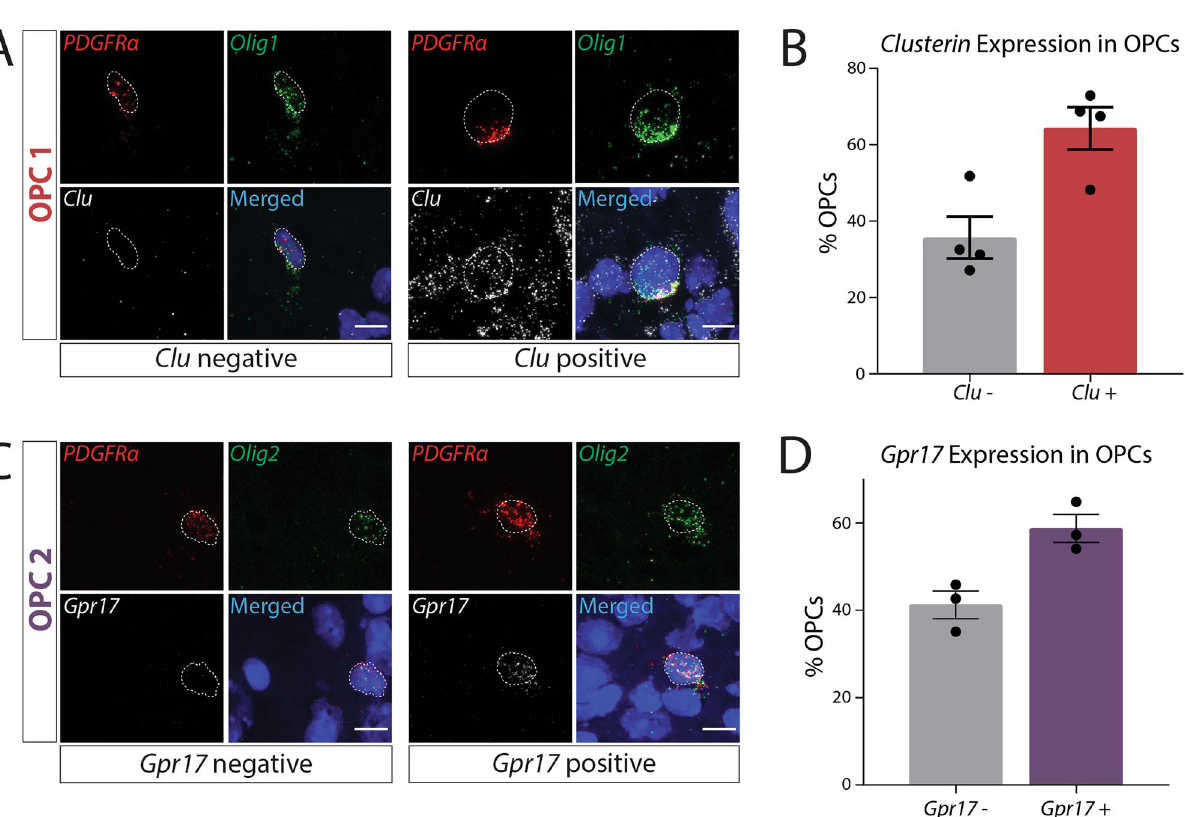
Figure 6. In vivo expression of cluster markers Clusterin and Gpr17 in OPCs. ( A ) RNAscope expression of Pdgfrα (red), Olig1 (green), Clu (white), and Hoechst (blue). White dotted line indicates the nuclear outline. ( B ) Quantification of Clu + and Clu − OPCs (depicted in ( A ); N = 2 independent experiments, n = 4 individual mice (2 males and 2 females) with 206 total cells analyzed). Each sample includes quantification of OPCs from the cortex, hippocampus, corpus callosum, and cerebellum. ( C ) RNAscope expression of Pdgfrα (red), Olig2 (green), Gpr17 (white), and Hoechst (blue). White dotted line indicates the nuclear outline. ( D ) Quantification of Gpr17 + and Gpr17− OPCs (depicted in ( C ); N = 2 independent experiments, n = 3 individual mice (1 male and 2 females) with 204 total cells analyzed). Each sample includes quantification of OPCs from the cortex, hippocampus, corpus callosum, and cerebellum. In all RNAscope experiments, OPCs were identified as cells co-expressing an OPC surface marker ( Pdgfrα or Cspg4 ) and an oligolineage transcription factor ( Olig1 or Olig2 ). Scale bar = 10